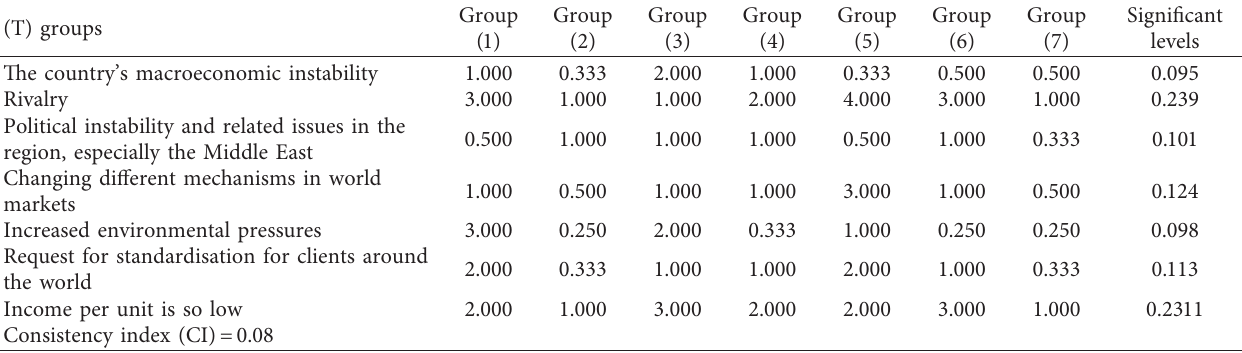
Table 8: Analogy matrix of (T) group.